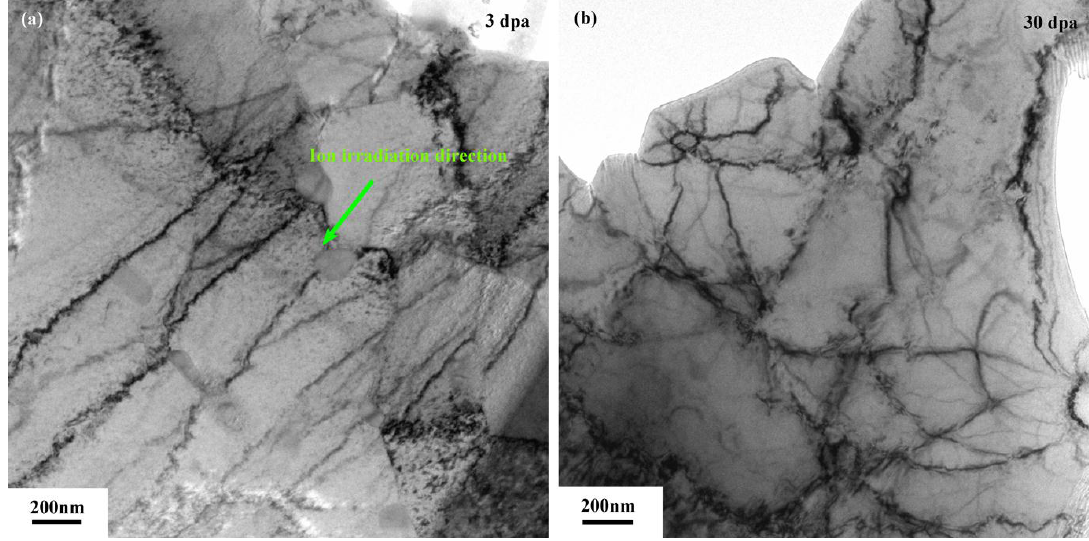
Figure 8. Dislocation density of different dose ion-irradiation samples, ( a ) 3 dpa; ( b ) 30